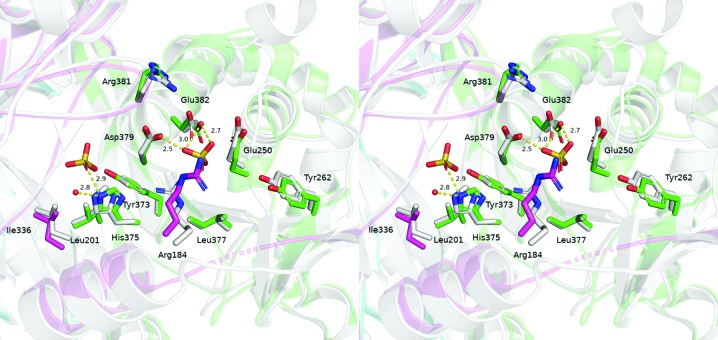
A stereo figure of the superposition of the region 4 active site of EcDSCD in P3121 (sulfate-bound; PDB entry 1c4t) and I4 (PDB entry 6pbr; this work) crystal forms. Chains A, B and C from PDB entry 1c4t are shown in green, cyan and purple, respectively. All of the chains from this work are shown in light grey. Sulfate molecules bind to three residues of the active site: His375, Asp379 and Glu382.